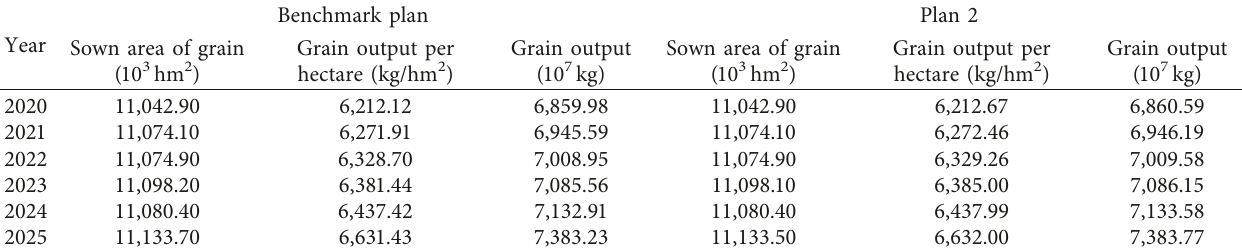
Table 7: Comparison of simulation results between Benchmark plan and Plan 2.